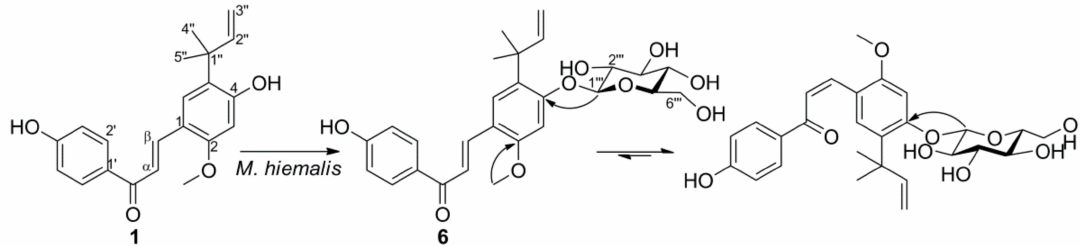
Figure 2. Microbial transformation of 1 by M. hiemalis . Selected HMBC correlations ( 1 H → 13 C) of metabolite 6 are indicated by